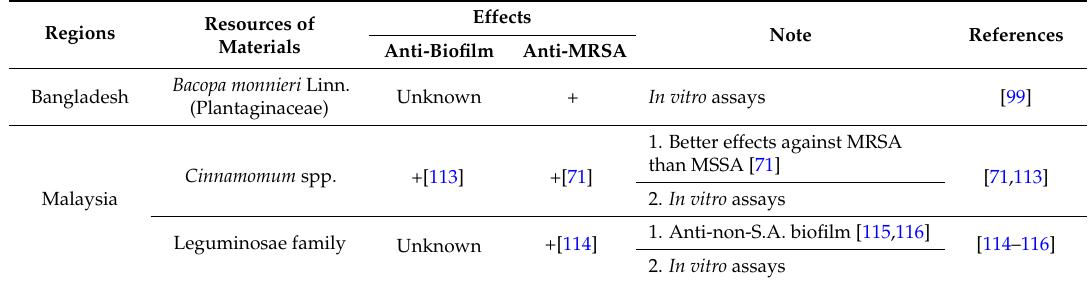
Table 2. Some ethnomedicinal materials with ethnomedical purposes for wound